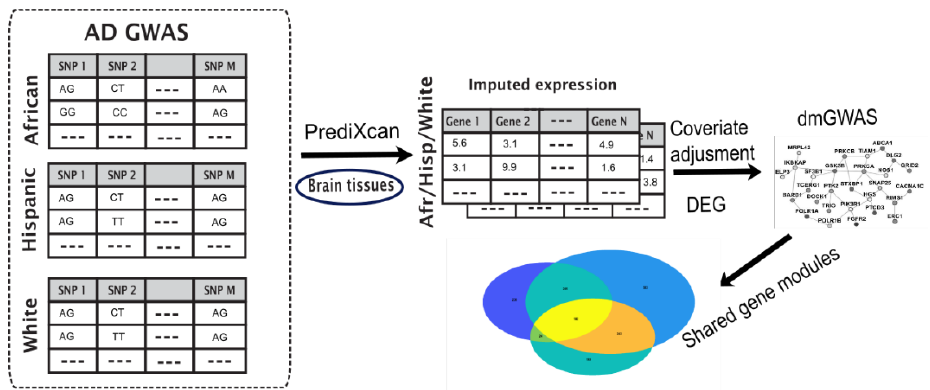
Figure 1. Illustration of the pipeline to identify shared gene modules between different populations. GWAS data is fed into PrediXcan for gene expression imputation, followed by adjustment for covariates and differential expression calculations. Genes with their p-values are fed into dmGWAS module to produce dense gene modules, which are compared to identify shared modules between populations.